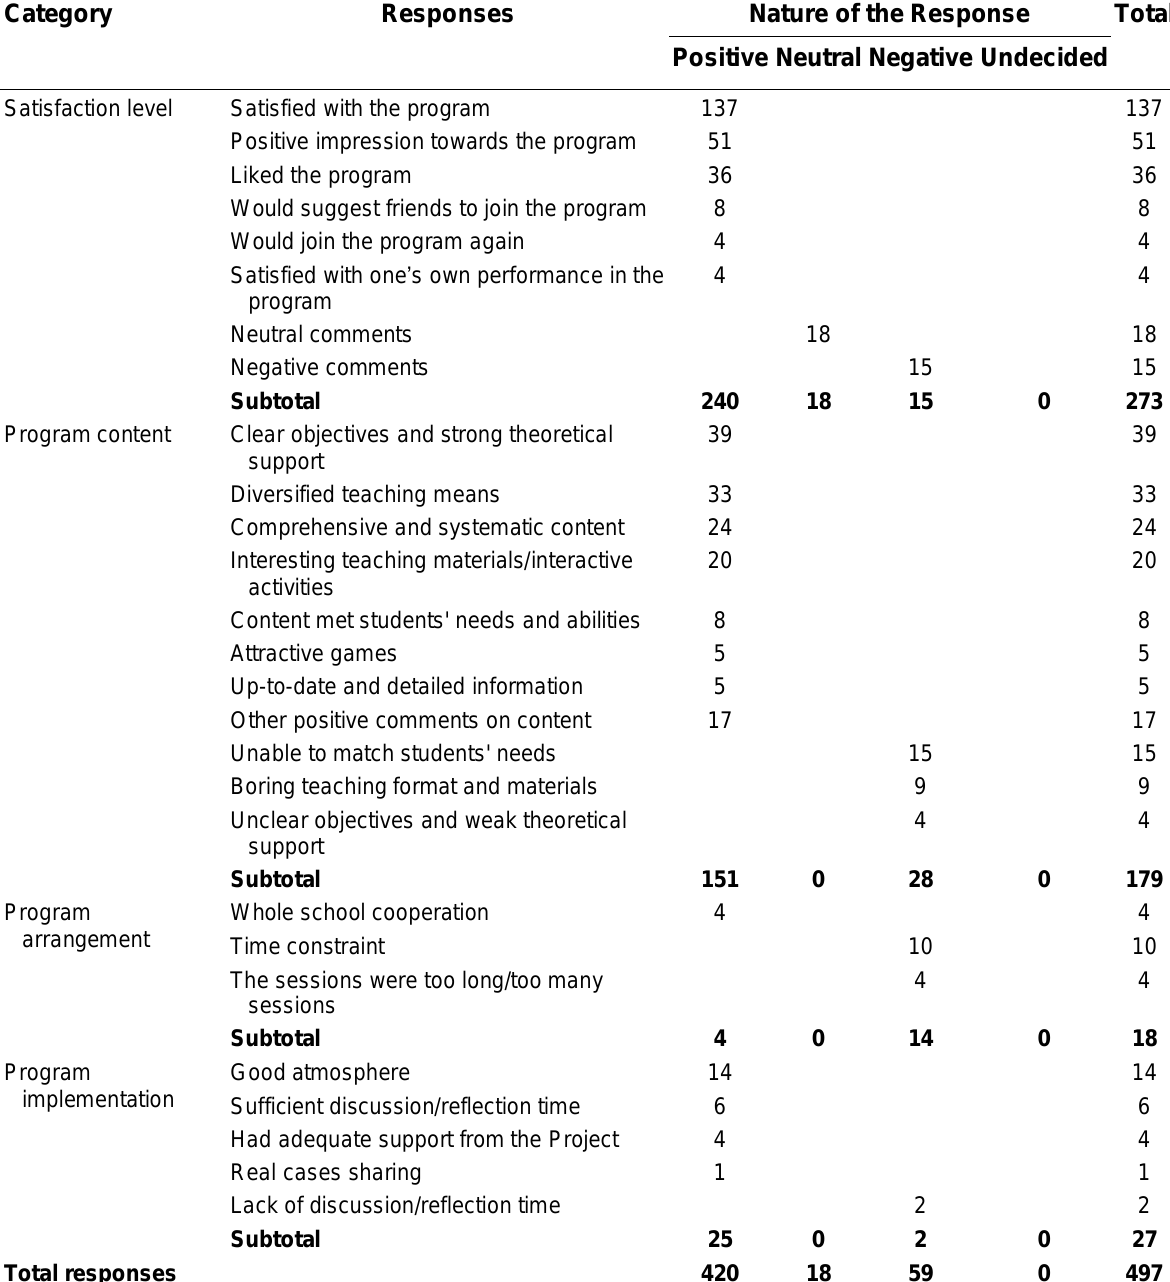
Responses Related to the Program Participants ’ and Instructors ’ Views on the